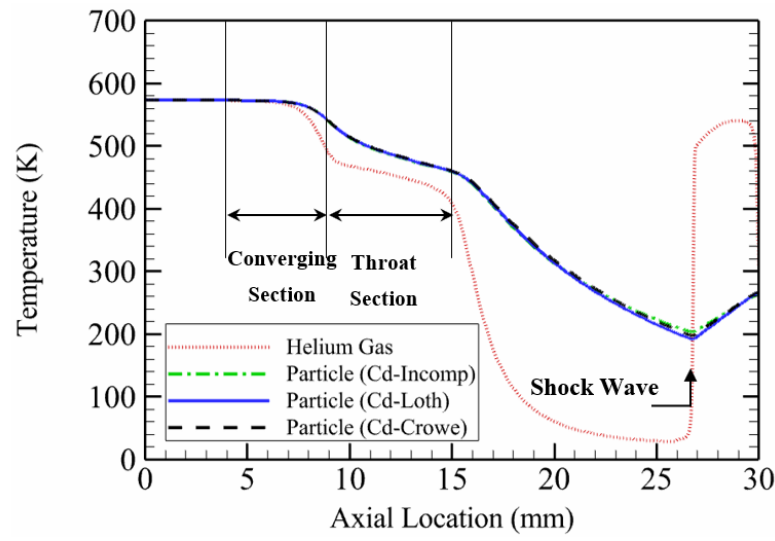
Figure 13. Effect of drag coefficients on centerline particle temperature, 𝑑 𝑝 = 5 μm .